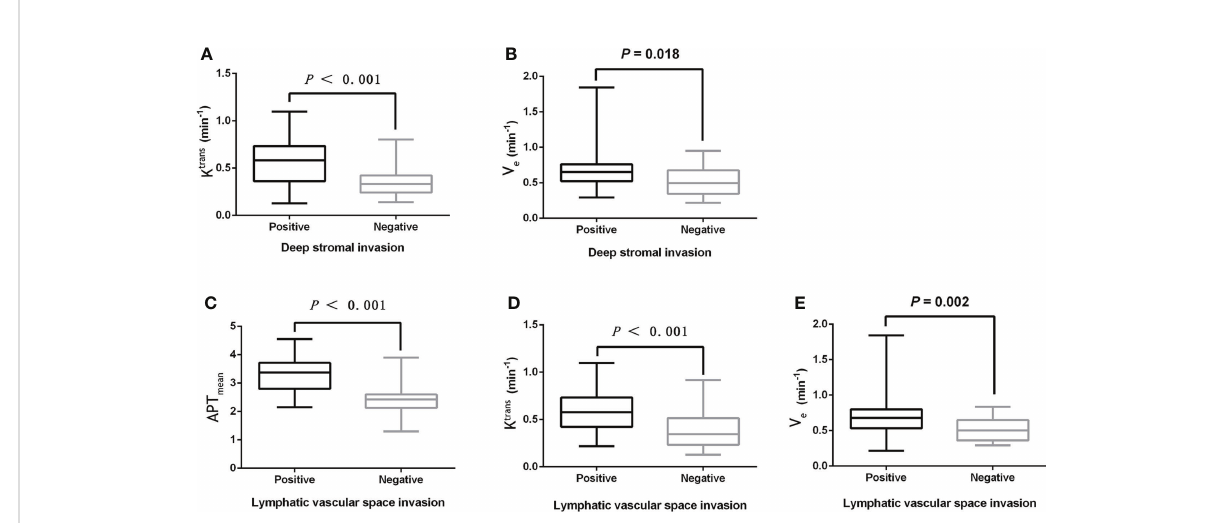
FIGURE 3 (A, B) The boxplot showing the difference of K trans and V e between the DSI positive and DSI negative groups. (C-E) Boxplots showing the difference of APT mean , K trans , and V e between the LVSI positive group and LVSI negative